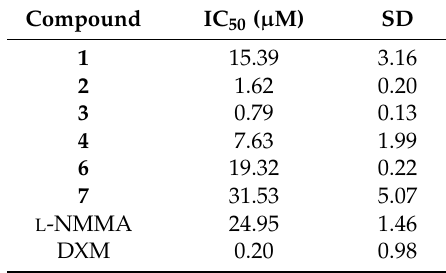
Table 2. Inhibitory effects of compounds against LPS-induced NO production in RAW264.7 Cells.